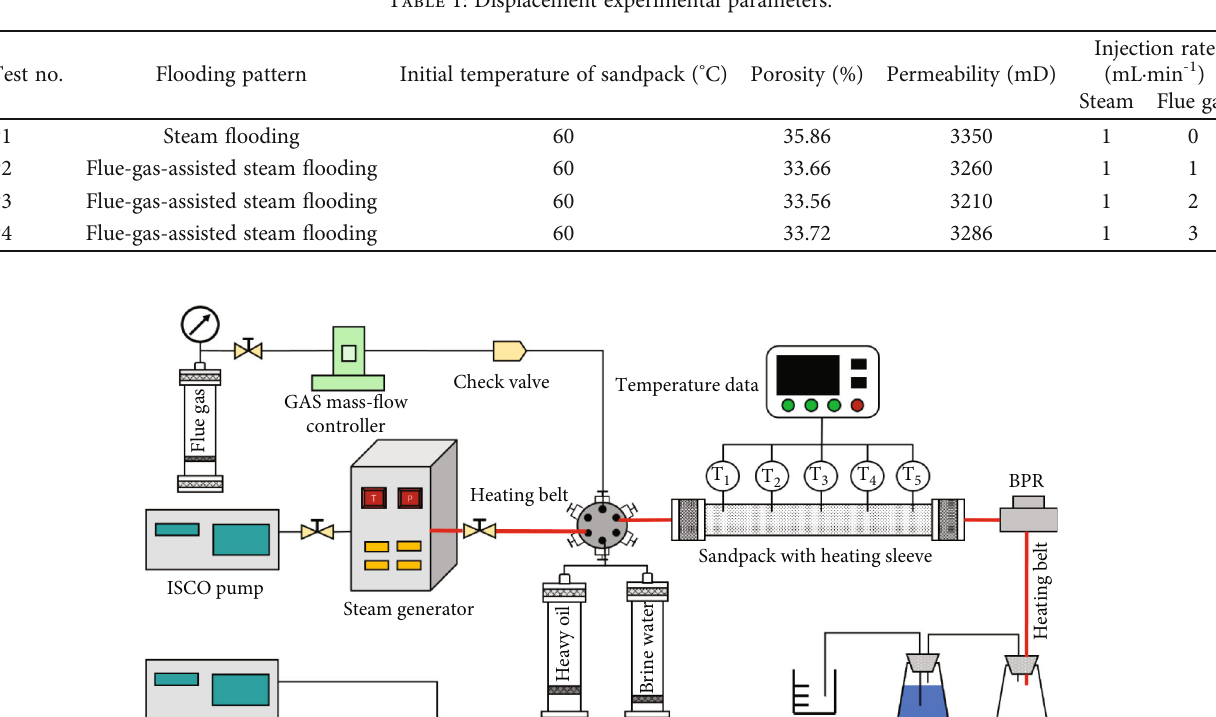
Table 1: Displacement experimental parameters.